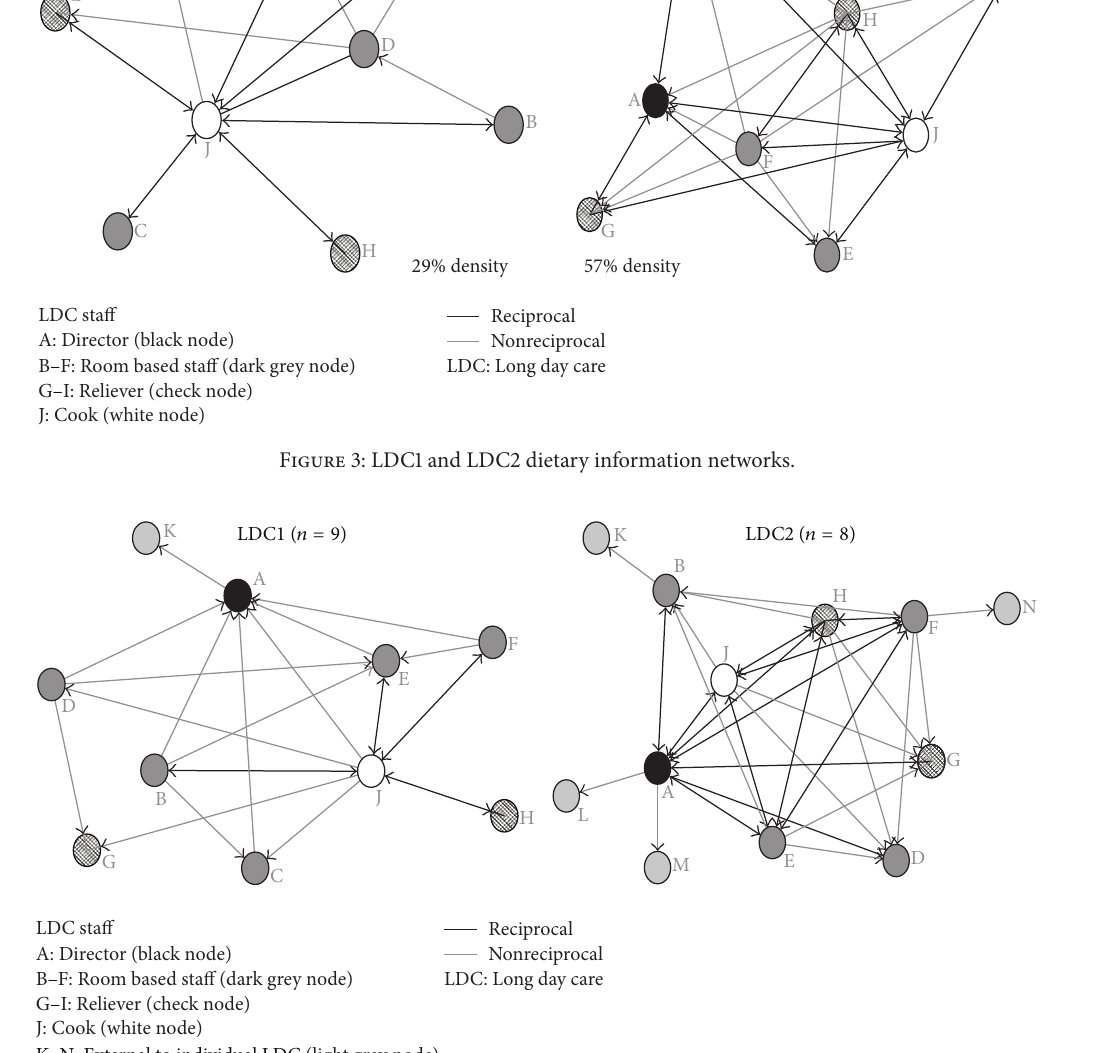
Figure 4: LDC1 and LDC2 policy information